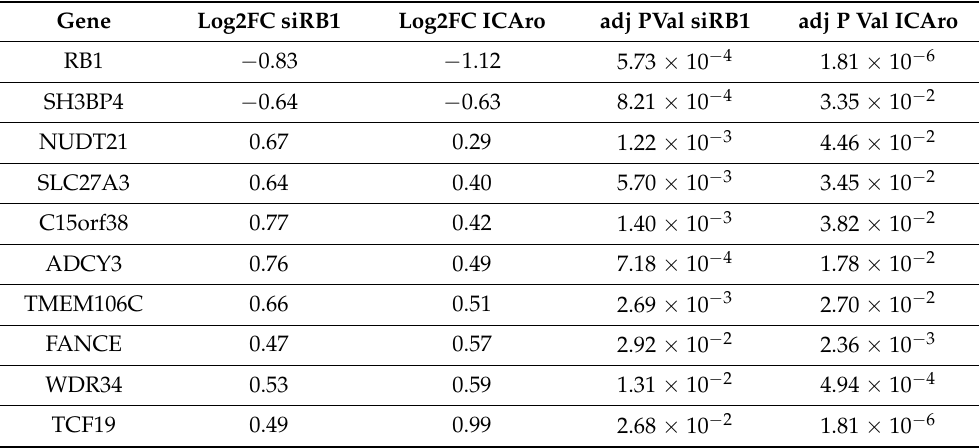
Table 1. The significant genes validated in the GSE76689 dataset from the ICAro system.